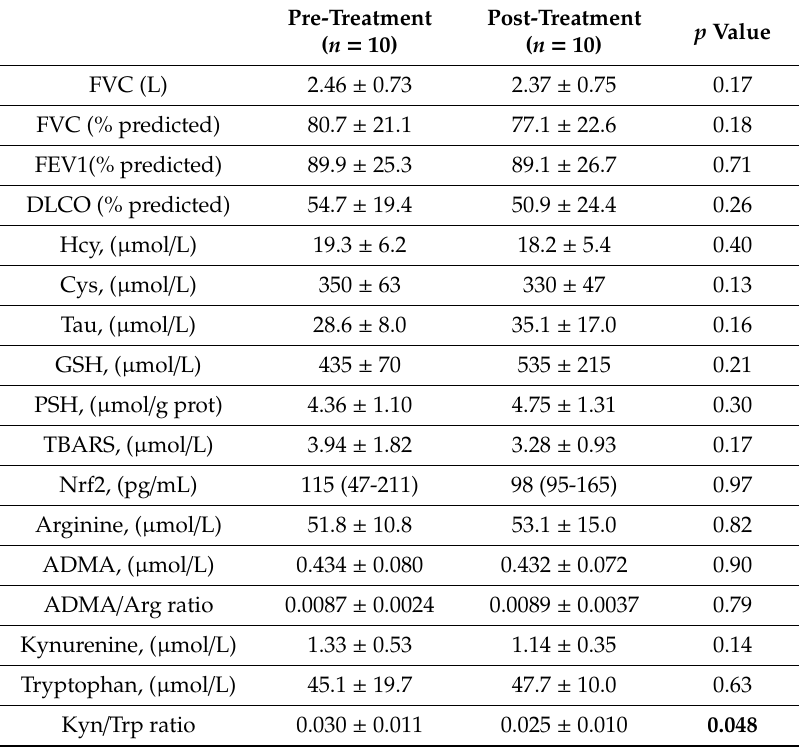
Table 3. Clinical and biochemical characteristics of IPF patients at baseline and after 24 weeks of pirfenidone treatment.